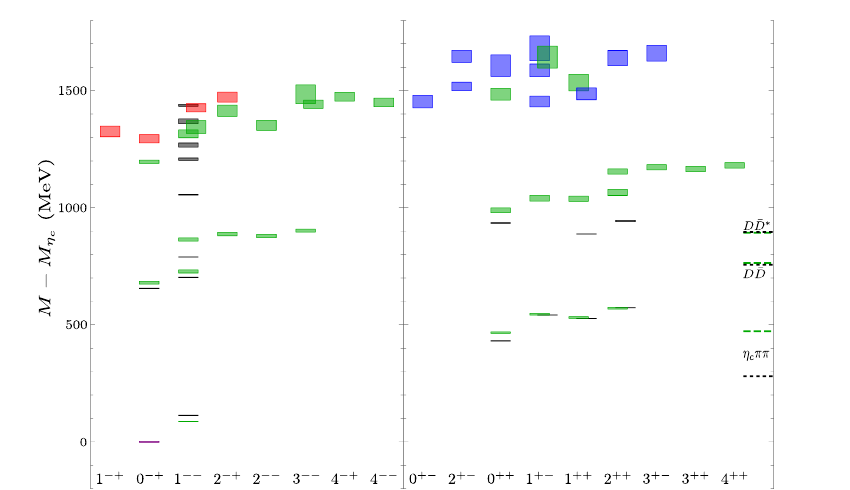
Figure 1. Charmonium spectrum from [7]. Results on the M π = 236MeV ensemble are compared to PDG (black). Many states (green) follow the n 2 S + 1 L J pattern of quark potential models. Excess states (red) and (blue) are also identified. They are consistent with being hybrid mesons coupled to a gluonic excitation ¯ cc g . Four of the hybrids have exotic quantum numbers J PC = 0 + − , 1 − + and 2 + − .